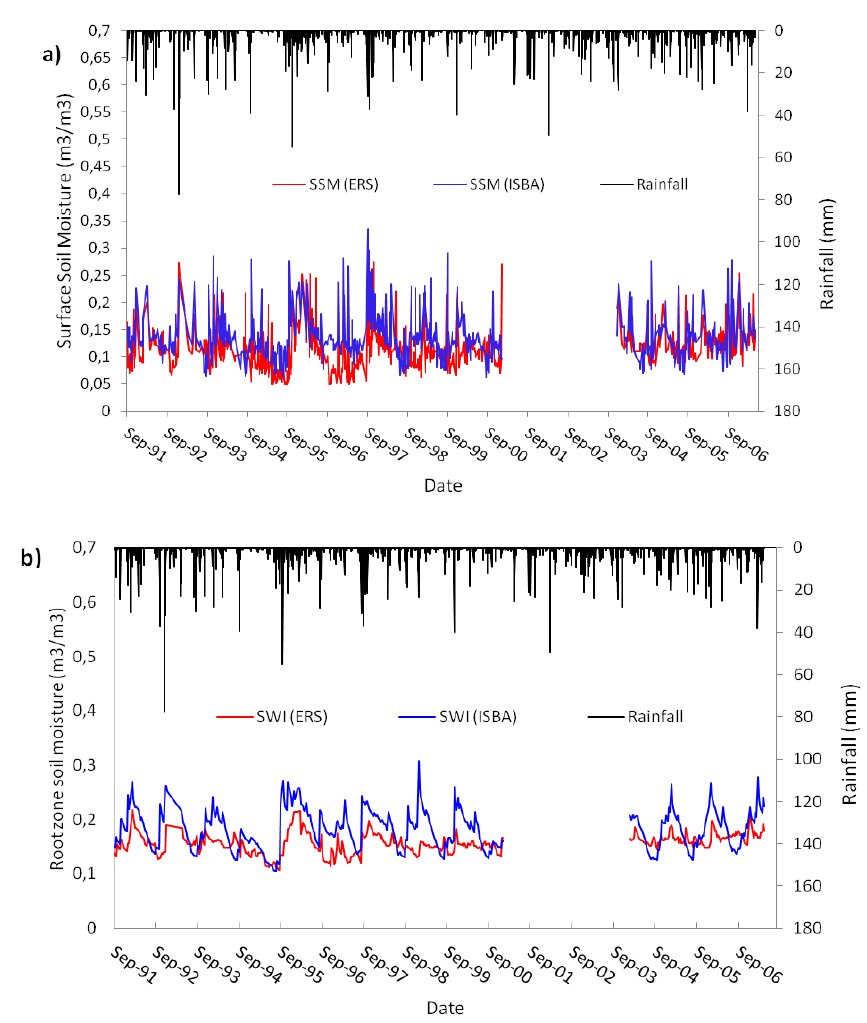
Figure 3. Inter-comparison between ISBA-A-gs soil moisture outputs and ERS/WSC products during the period from 1991–2007 (no data for 2001–2003): ( a ) surface